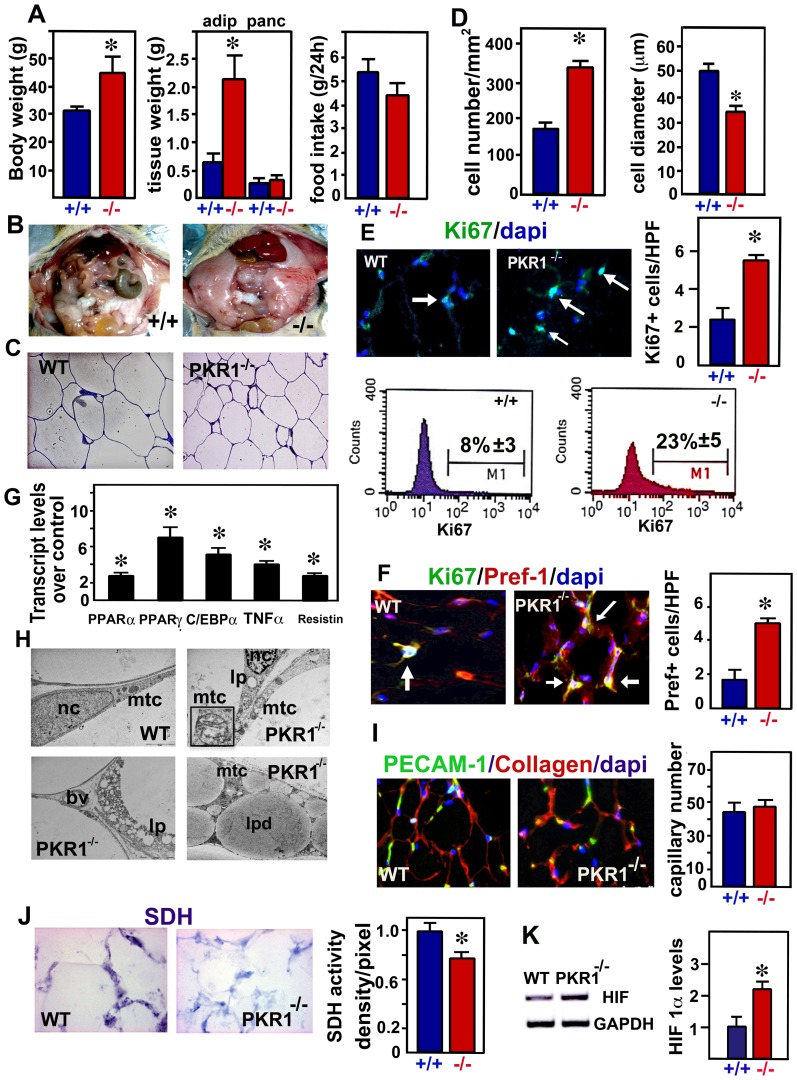
PKR1 null mutant mice (PKR1−/−) exhibit obesity at the later age.A) Body weight (g), and WAT and pancreas (pancr) weight (g), and food intake (g/24 h) at the age of 40 weeks (*p<0.05, n = 6). B) Representative illustration of abdominal obesity in PKR1−/− mice. C) Representative illustration of semi-thin sections of adipocyte tissue derived from PKR1−/− and WT mice. D) Histograms show cell number and diameter differences between these two groups of mice. E) Representative illustration of Ki67 positive cells (green) and dapi positive total cells (blue) in adipose tissue of PKR1−/− and WT mice. Quantification of Ki67+ cell numbers in the high power field (HPF, ×40 objective) (*p<0.05, n = 20 HPF). Flow cytometery for Ki67 positive nuclei in the cells that were prepared from PKR1−/− and WT type abdominal (epididymal and visceral) WATs tissue after removal of adipocytes. F) Representative illustration and quantification of pref-1+/Ki67+ positive cells (orange) and dapi positive total cells (blue) in adipose tissue of PKR1−/− and wild type mice (*p<0.05, n = 20 HPF, ×40 objective). G) qPCR analyses of transcript levels of adipogenic genes of PKR1−/− mice over WT mice (fold increase). H) Representative illustration of electron microscopic analyses of adipose tissues derived from PKR1−/− and WT mice demonstrating cytoplasmic lipid droplets (lp) and swollen mitochondria (mtc). Nc: nucleus, bv: blood vessel. I) Illustration and histogram shows the PECAM-1 staining and capillary formation are similar between the adipose tissues of PKR1−/− and WT mice (p<0.05, n = 20 HPF, ×40 objective). J) Illustration and histogram shows the succinyl dehydrogenase (SDH) staining changes between the adipose tissues of PKR1−/− and WT mice (*p<0.05, n = 20 HPF, ×40 objective). K) Western blots analyses reveal a high level of HIF-1α levels in PKR1−/− mice (*p<0.05, n = 3).